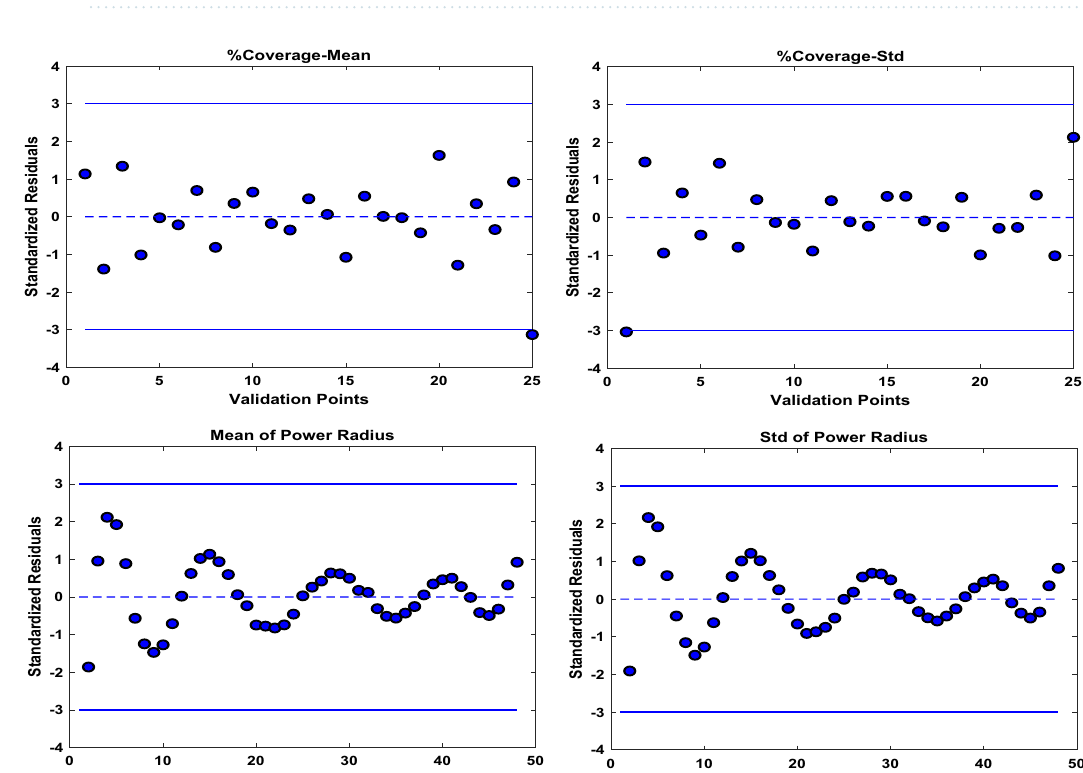
Figure 7. Scatterplots for the cross-validation of the Kriging surrogates. Shown are the standardized residuals in the range of [− 3, 3 ] for the mean and Std of coverage and power